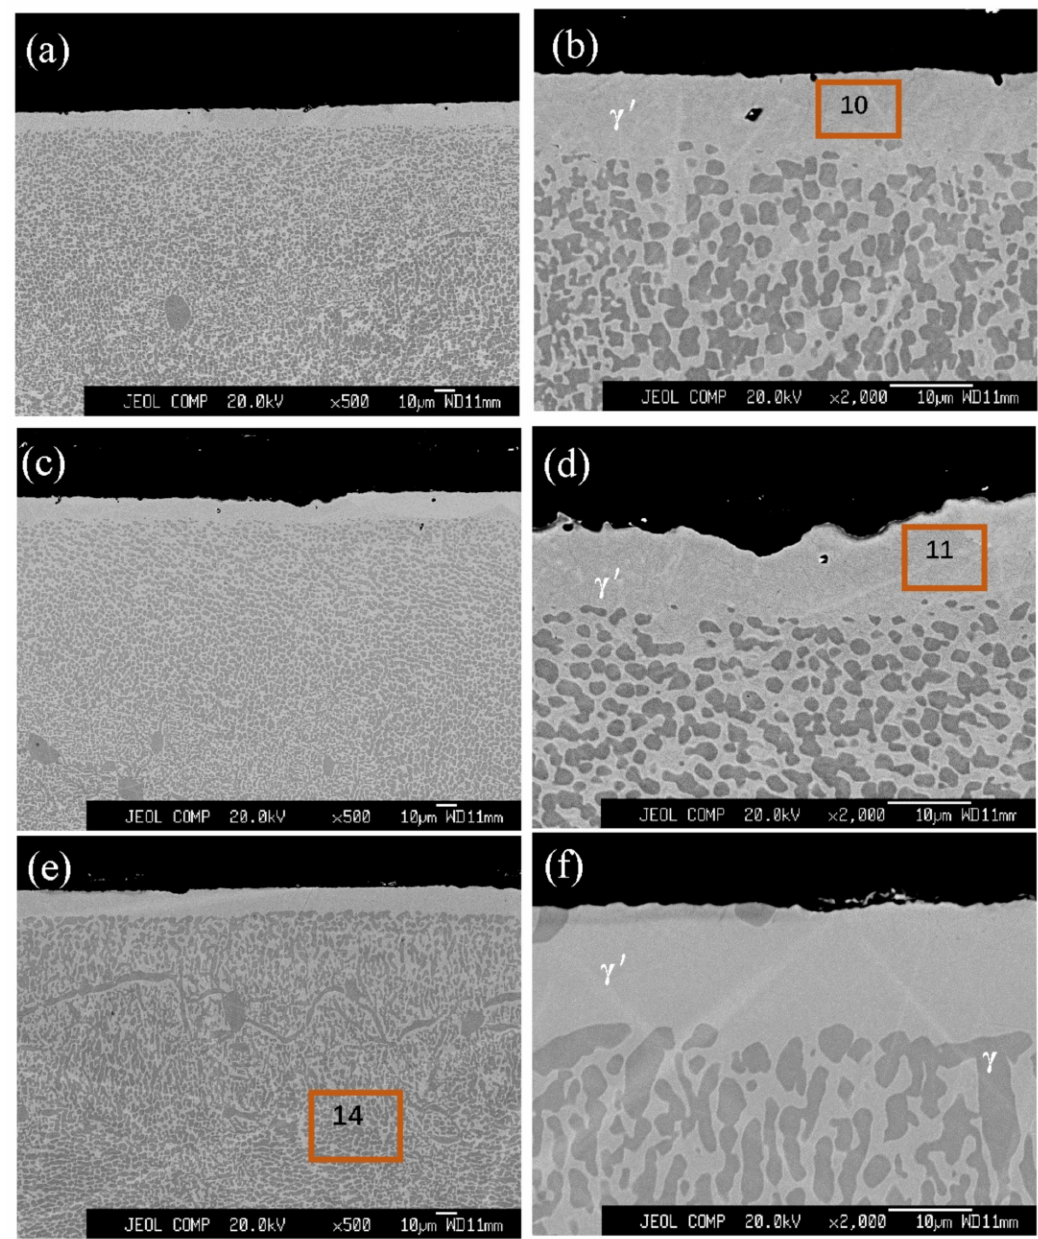
Figure 3. The cross-section morphology of IC21 substrate without coating after 50 h ( a , b ), 150 h ( c , d ) and 200 h ( e , f ) thermal